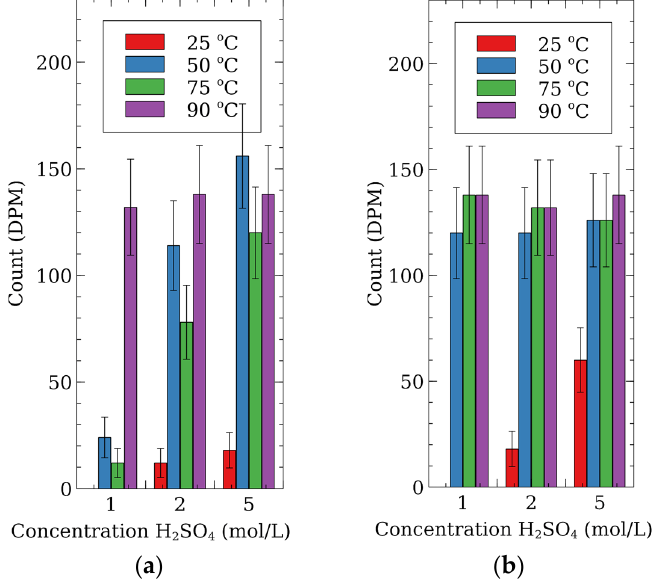
Figure 4. Activity of the decontamination solution depending on the concentration of H 2 SO 4 , tem- perature, and contact time: ( a ) 24 h, ( b ) 48 h.